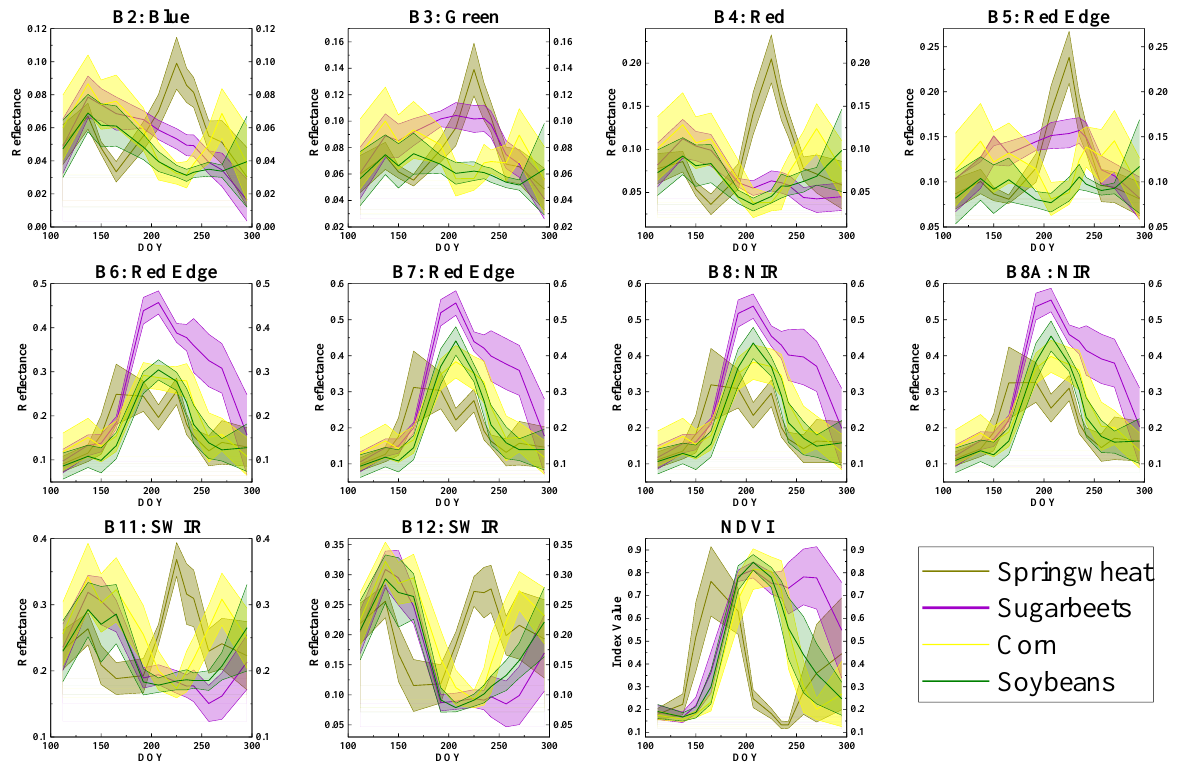
Figure 8. Time-series spectral band and vegetation indices are aggregated for crop fields. The buffers indicate one standard deviation calculated from the fields.